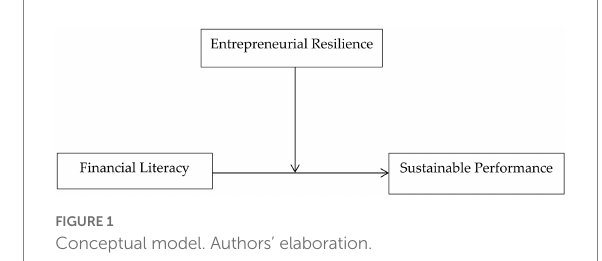
FIGURE 1 Conceptual model. Authors’